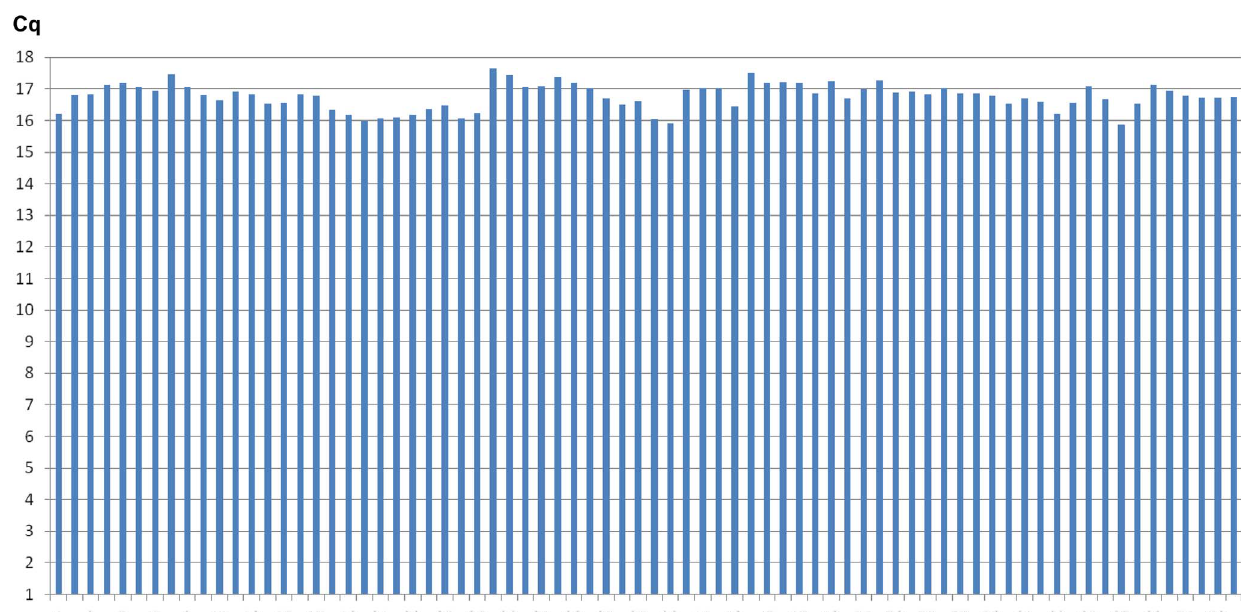
Figure 1. Extraction from serum and RT-qPCR of the spike-in control cel-miR-39 were performed with minimal variation between samples (CV 2.4% for AS patients [ # 1–36 and # 38–58] and 2.2% for the control subjects [ # 59–74]), which indicates that miRNAs seem to meet the analytical requirements proposed for novel biomarkers. Data are presented as the absolute Cq values.